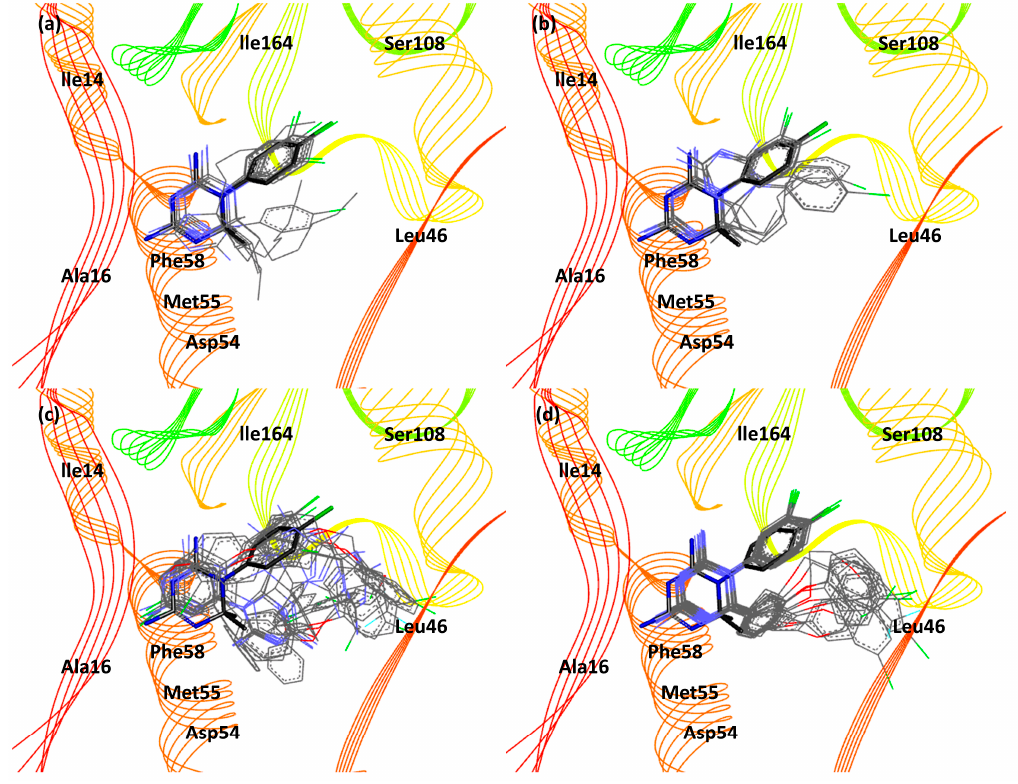
Figure 5. Superposition image of Cyc derivatives ( p- and m- chlorophenyl substituent) with the reference structure in the wild-type pf DHFR binding pocket. Cyc24–31 and Cyc42 (R 2 is alkyl chain) in ( a ) R configuration and ( b ) S configuration. Cyc32–41 and Cyc43–46 (R 2 is phenol chain) in ( c ) R configuration and ( d ) S configuration. Cycloguanil derivatives and the reference structure are shown as line model and stick model, respectively. Black, blue, and green indicates carbon, nitrogen, and chlorine atom, respectively.